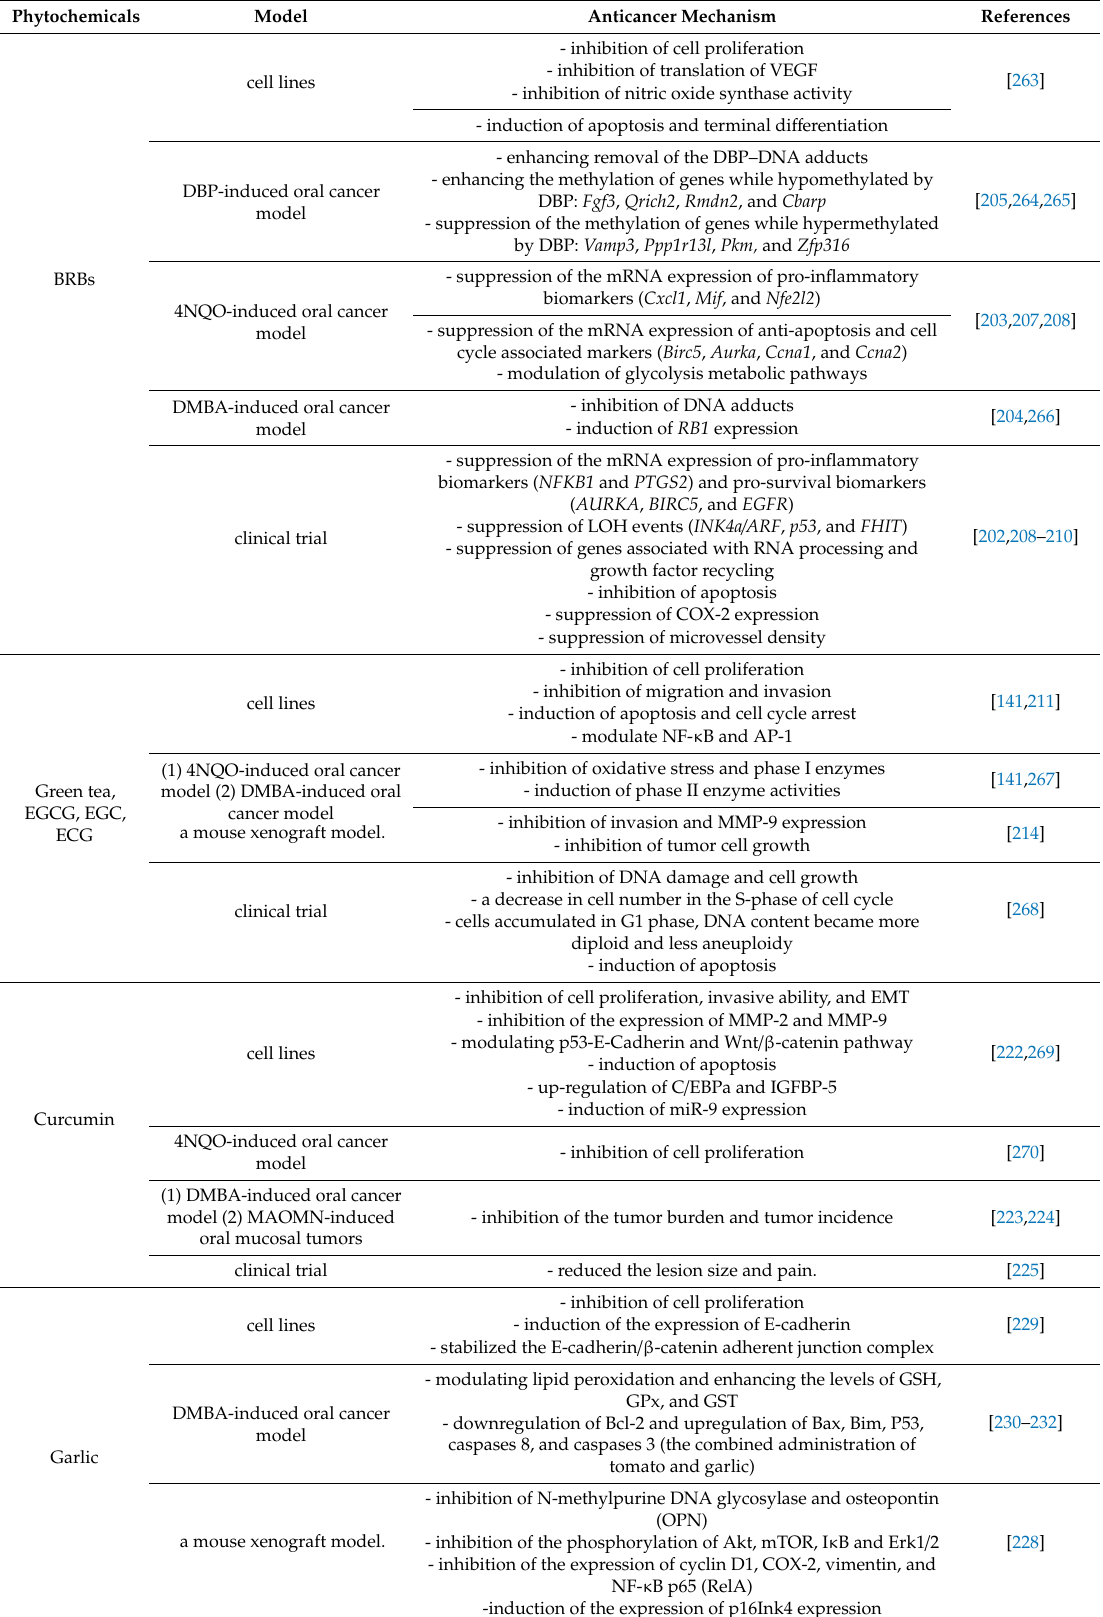
Table 1. Main anticancer mechanism regulated by natural phytochemicals in oral